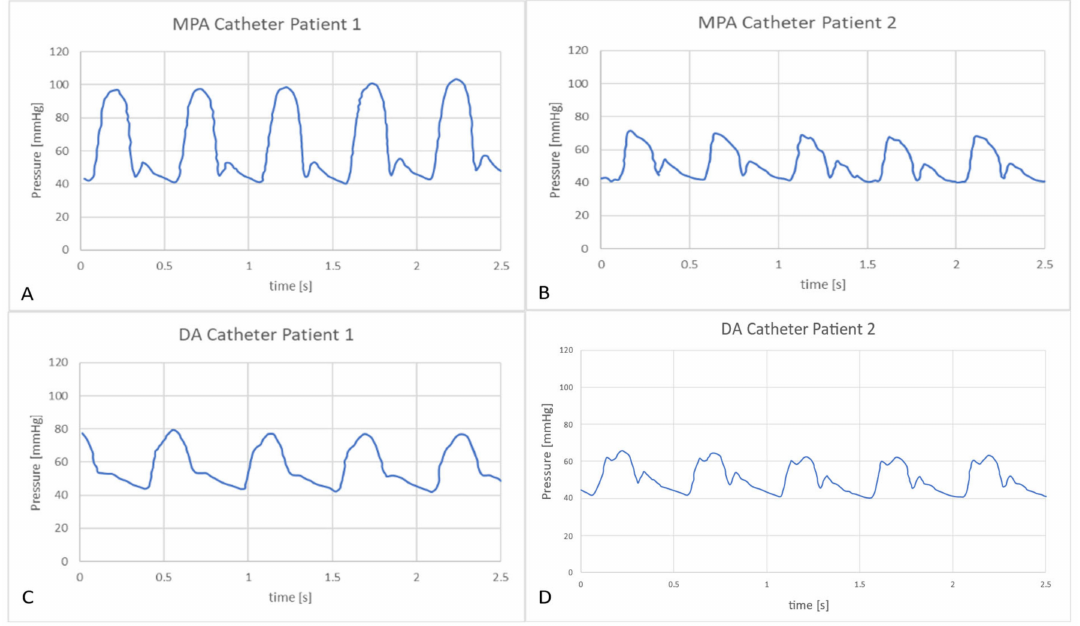
Figure 20. Catheter tracings of pressure waveforms in the MPA ( A , B ) and DA ( C , D ) conduits for patients 1 and 2